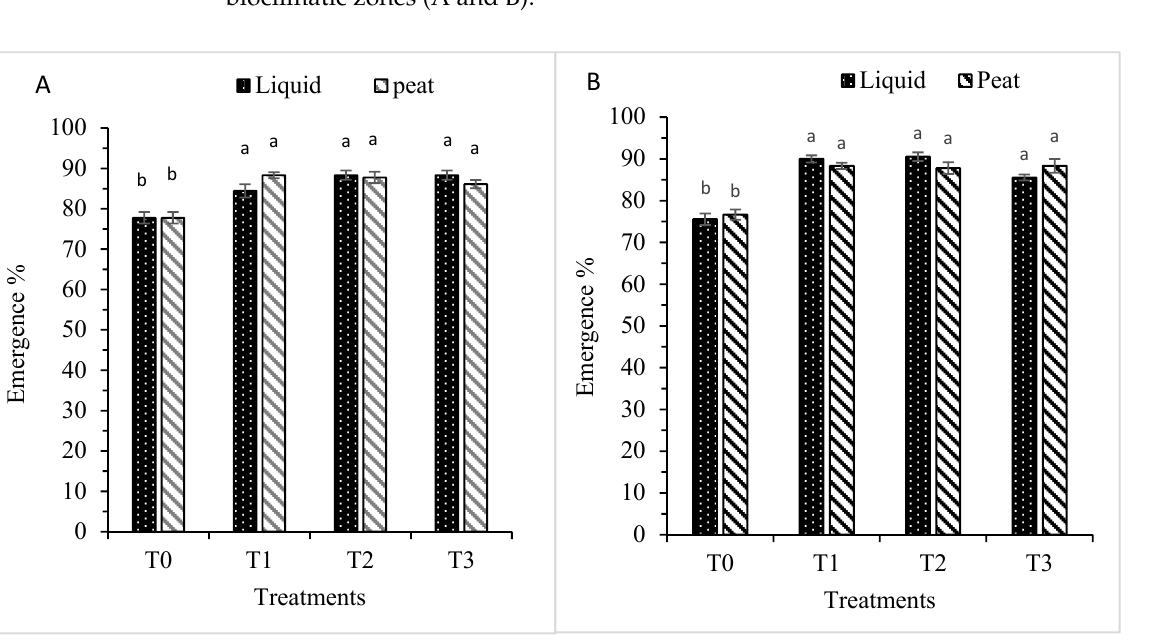
Figure 1. Plant emerging rate of soybean plants subjected to liquid formulation (T0 = 0 mL, T1 = 150 mL, T2 = 300 mL and T3 = 150 mL) and peat formulation of Bradyrhizobium japonicum (T0 = 0 g, T1 = 250 g, T2 = 500 g and T3 = 150 mL) in bioclimatic zone (( A ) = Bronkhorspruit/Gauteng) and (( B ) = Hartbeesfoein/North West province). Bars sharing a letter are not significantly different (Lsd zone A) = 5.139 and (Lsd zone B) = 5.442. Data are means ± standard